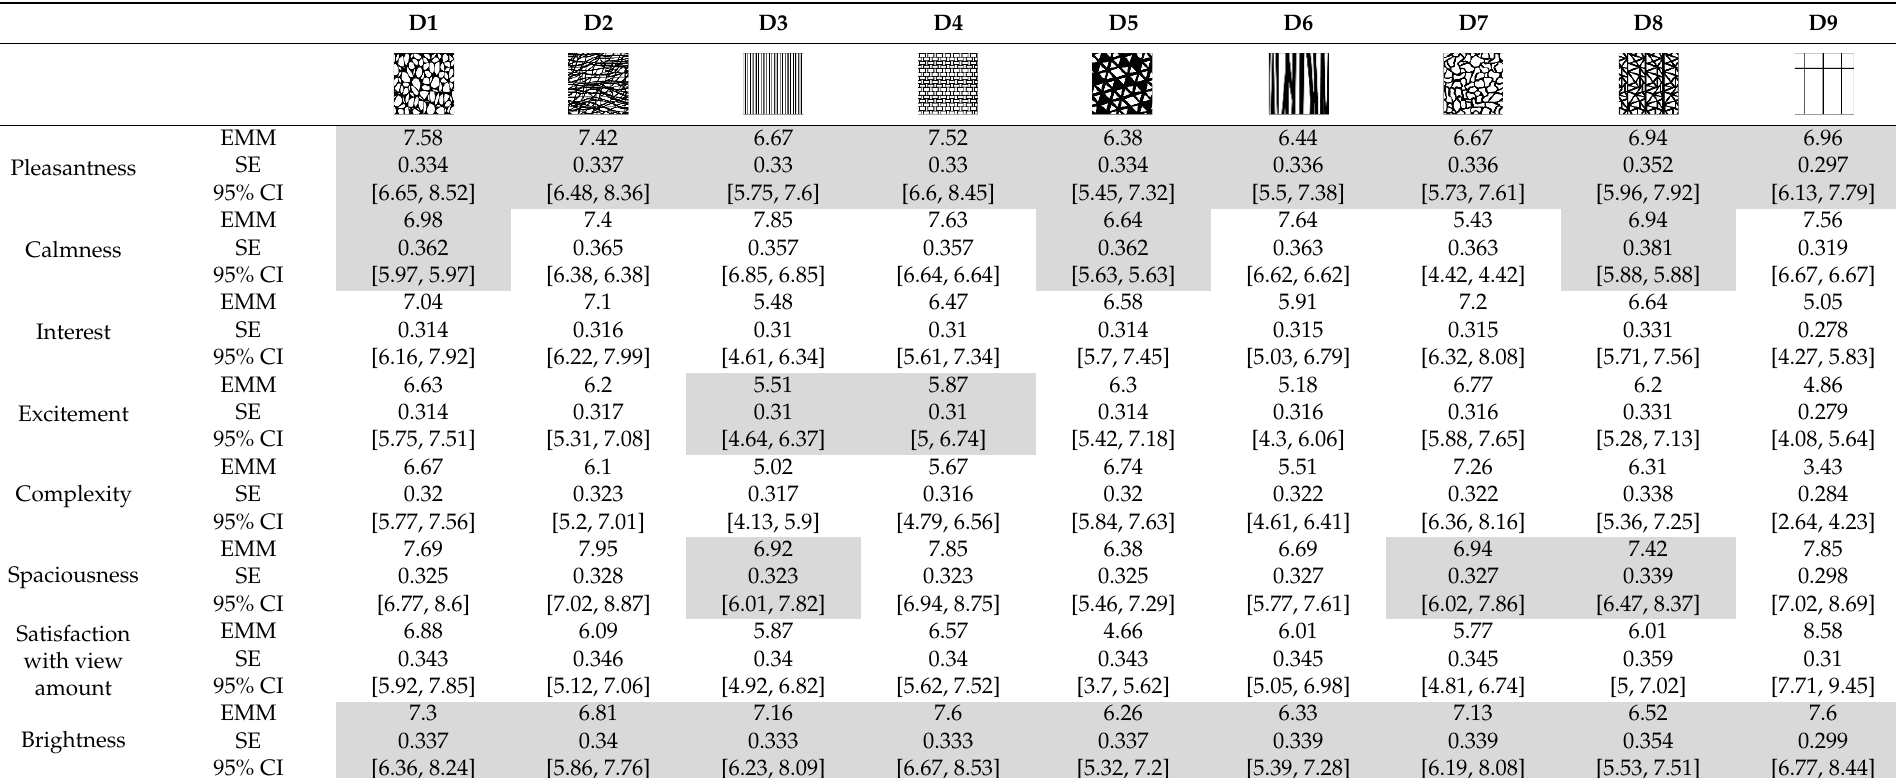
Table 5. Estimated marginal means (EMM), standard errors (SE) and 95% confidence intervals (CI) per attribute and aperture design (without interaction).